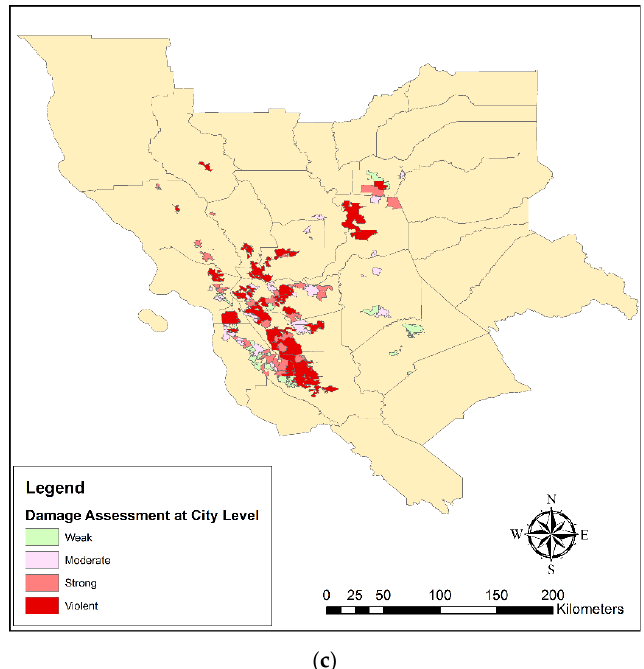
Figure 11. The estimated damage map from ( a ) Naive Bayes, ( b ) SVM, and ( c ) deep learning algorithms at the city scale.